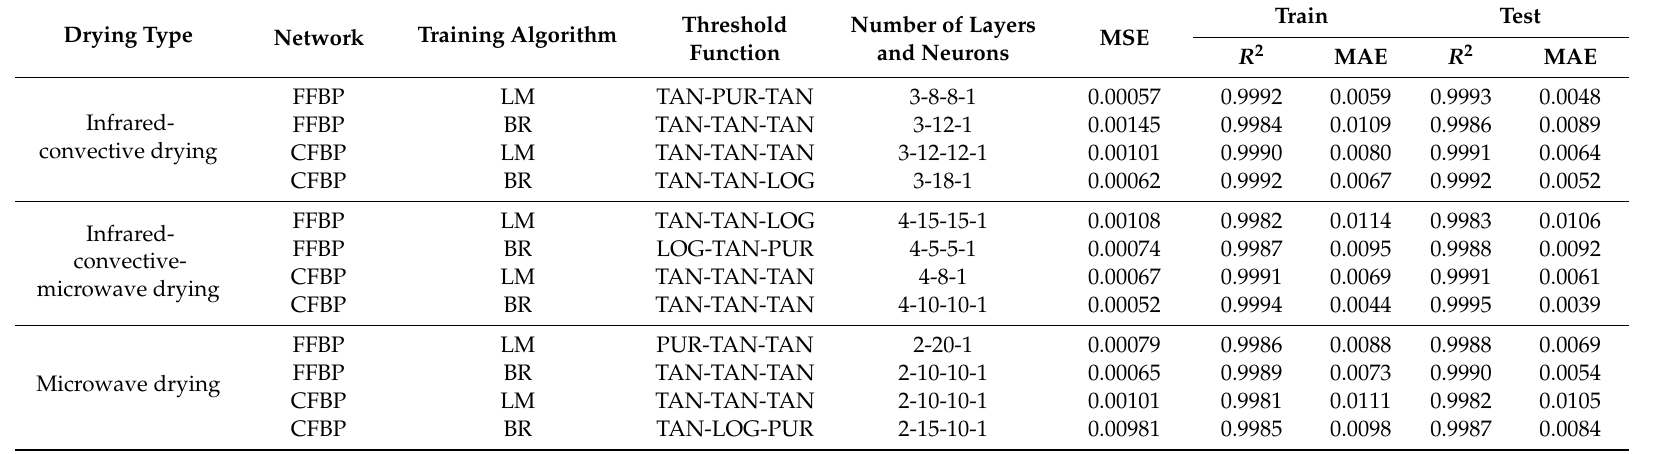
Table 2. The best selected topologies including training algorithm, di ff erent layers and neurons for FFBP and CFBP for moisture ratio in infrared convection, infrared-convective-microwave and microwave